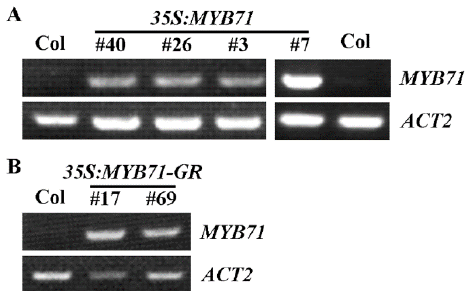
Figure 3. Expression of MYB71 in the 35S:MYB71 and 35S:MYB71-GR transgenic plants. ( A ) Expression of MYB71 in the 35S:MYB71 transgenic plants. ( B ) Expression of MYB71 in the 35S:MYB71-GR transgenic plants. Total RNA was isolated from 10-day-old homozygous transgenic plants and RT-PCR was used to examine the expression of MYB71 . Expression of ACT2 was used as a control. There is one T-DNA insertion line for MYB71 available from TAIR, we therefore isolated the single mutant myb71-1 from the T-DNA insertion line (Figure 4A).